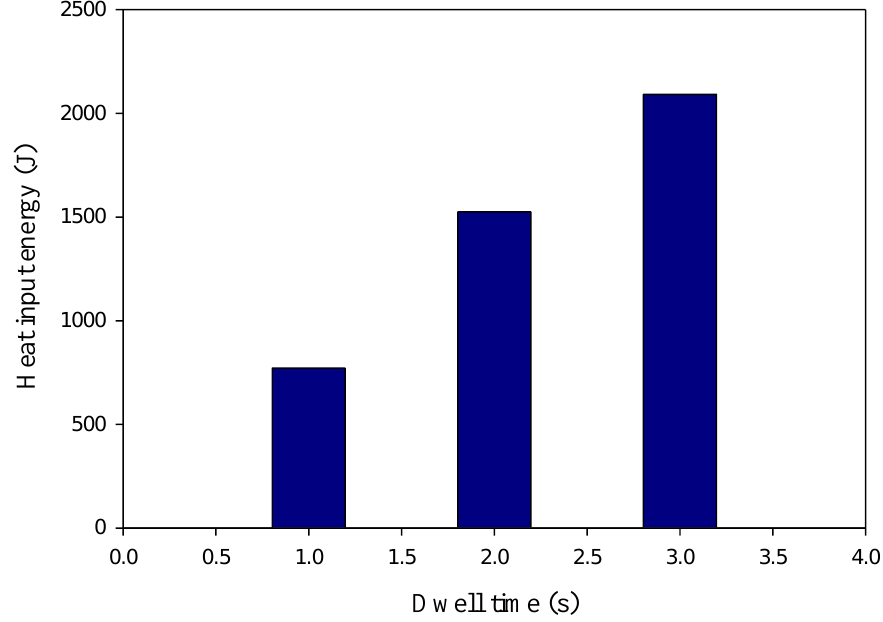
Figure 5. The relation of heat-input energy versus the used dwell time for the AA5052-H32 FSSWed materials processed at 500 rpm.